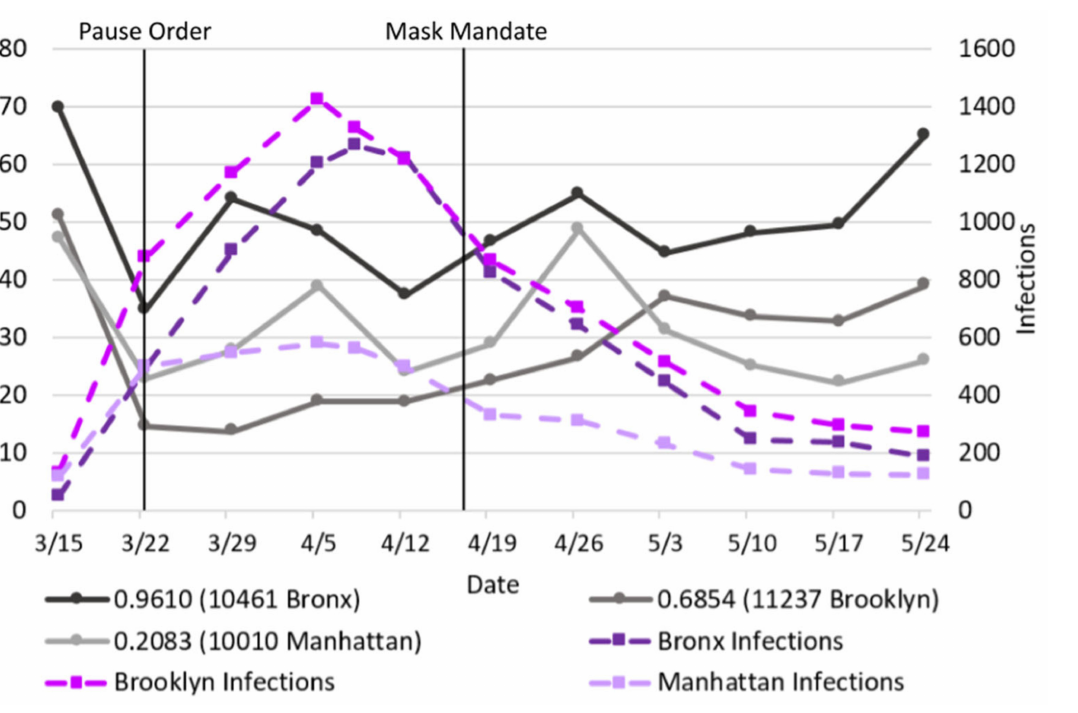
Figure 4. Seven-day average of the percentage of the previous year’s daily visits (15 March to 30 May 2019 vs. 2020) at 3 NYC McDonald’s, alongside the total 7-day rolling average infection case